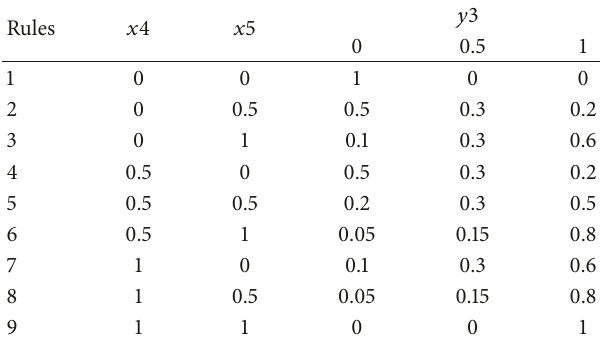
Table 6: The fuzzy gate rules for thermal bending of rotor’s quality.